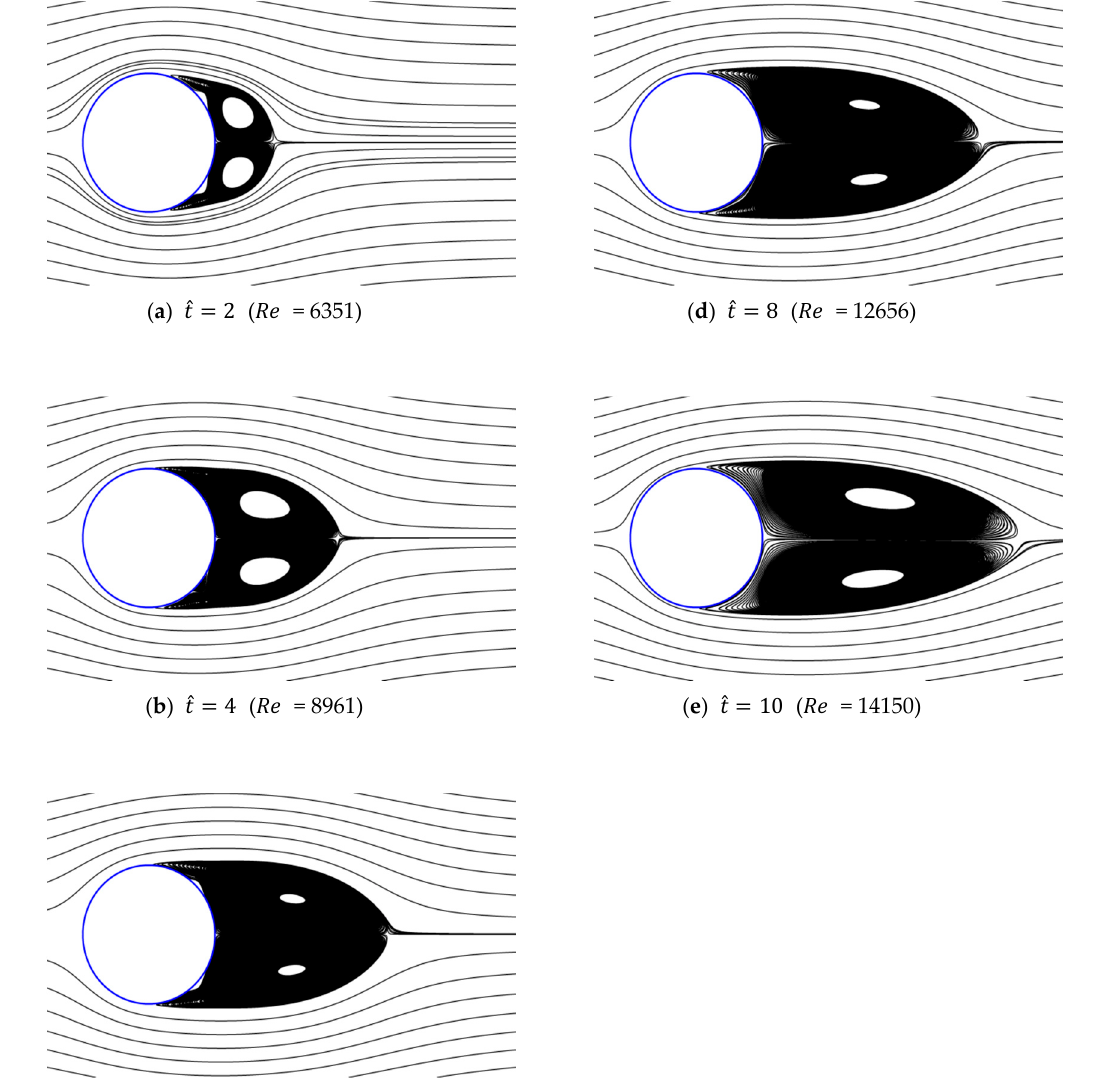
Figure 14. Streamlines around circular cylinder ( a / g = 0.5, Re 0 = 40 )